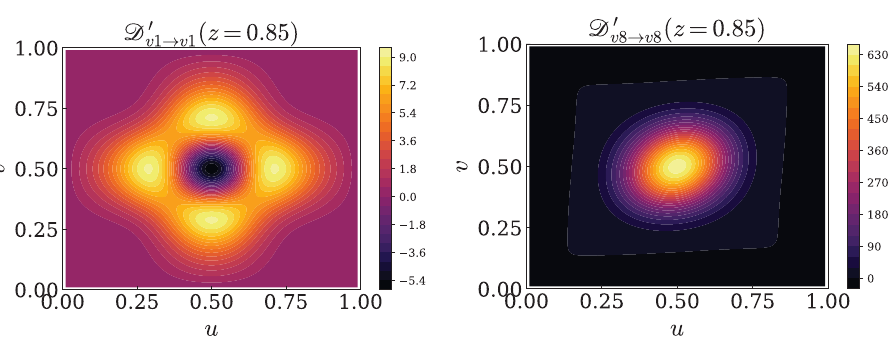
Figure 1. Contour plots of (cid:10) (cid:8) (Left) and (cid:10) (cid:8) (Right) for z = 0.85 in ( u , v ) -space. The v 1 → v 1 a 8 → a 8 sidebar on each panel represents the numerical value of the derivative in arbitrary units; the lighter the sidebar’s color, the larger the derivative’s